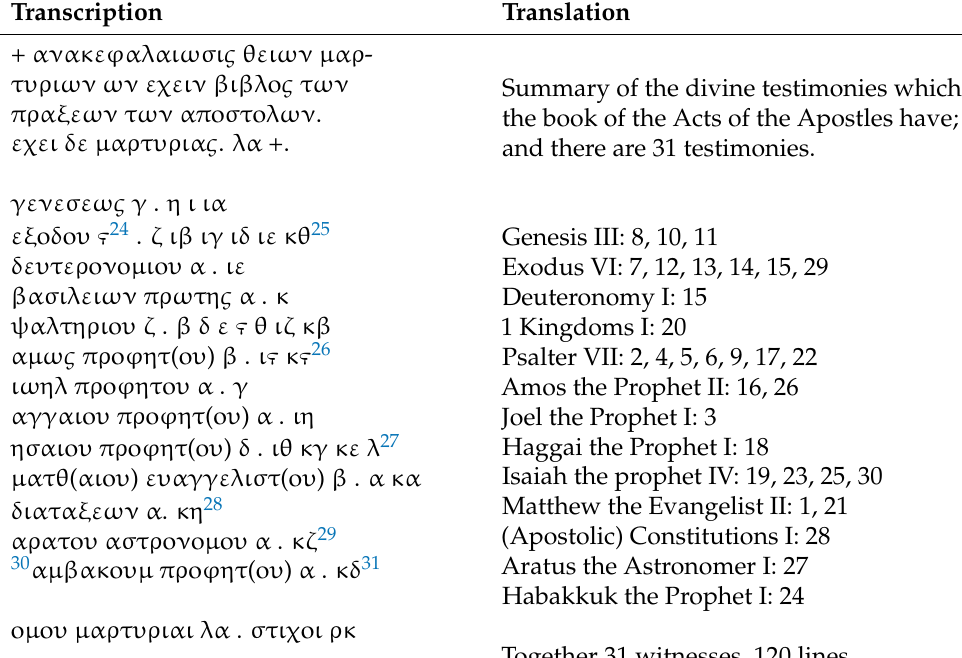
Table 1. The short quotation list to Acts in GA 1162.